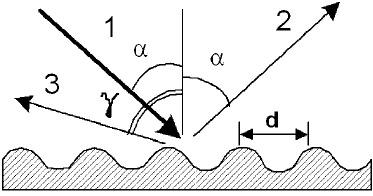
FIG. 1. Splitting of the wave beam incident on the diffraction grating (1) into two, mirror (2) and diffraction (3)